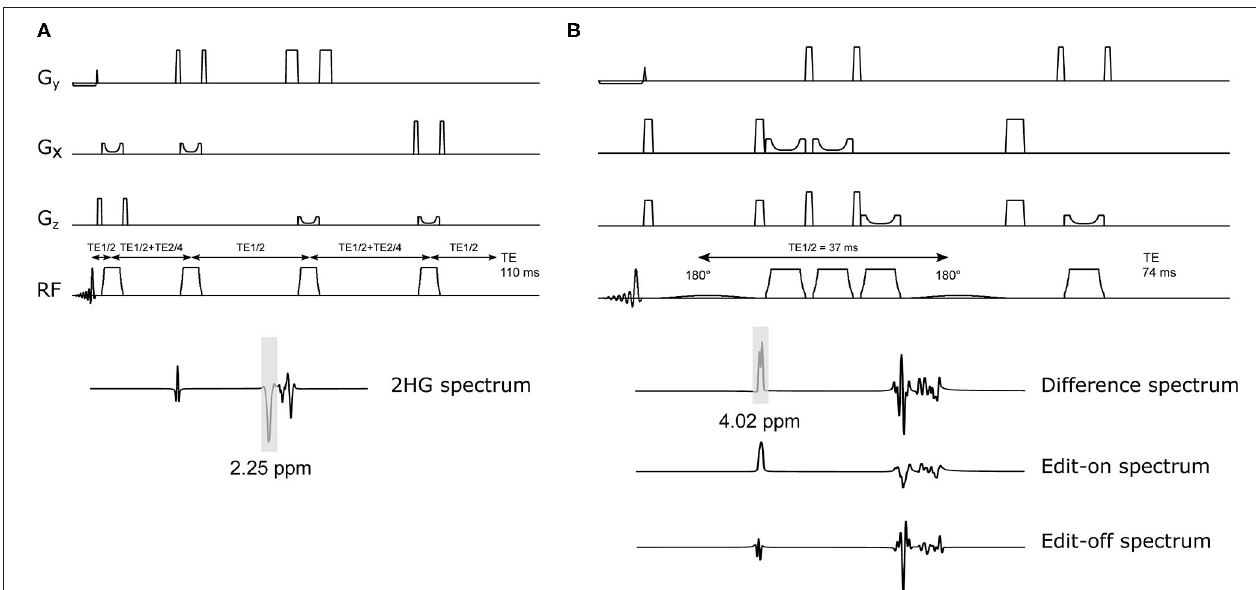
FIGURE 1 | Schematic of 2HG-optimized sLASER and MEGA-sLASER with their corresponding simulated 2HG spectra. (A) sLASER sequence with 2HG-optimized TE of 110ms (TE1, TE2, and TE3 = 11, 65, and 34ms). The bandwidth of the FOCI pulses in both sequences is ∼ 11kHz (10.78kHz). (B) MEGA-sLASER sequence with two 180 ◦ frequency selective pulses centered at 2HG β frequency (1.9 ppm) and two pairs of FOCI pulses for adiabatic localization. The frequency selective pulses are Gaussian (truncated at 10%) with bandwidth = 88Hz. The difference spectrum is obtained by the subtraction of Edit-on and Edit-off